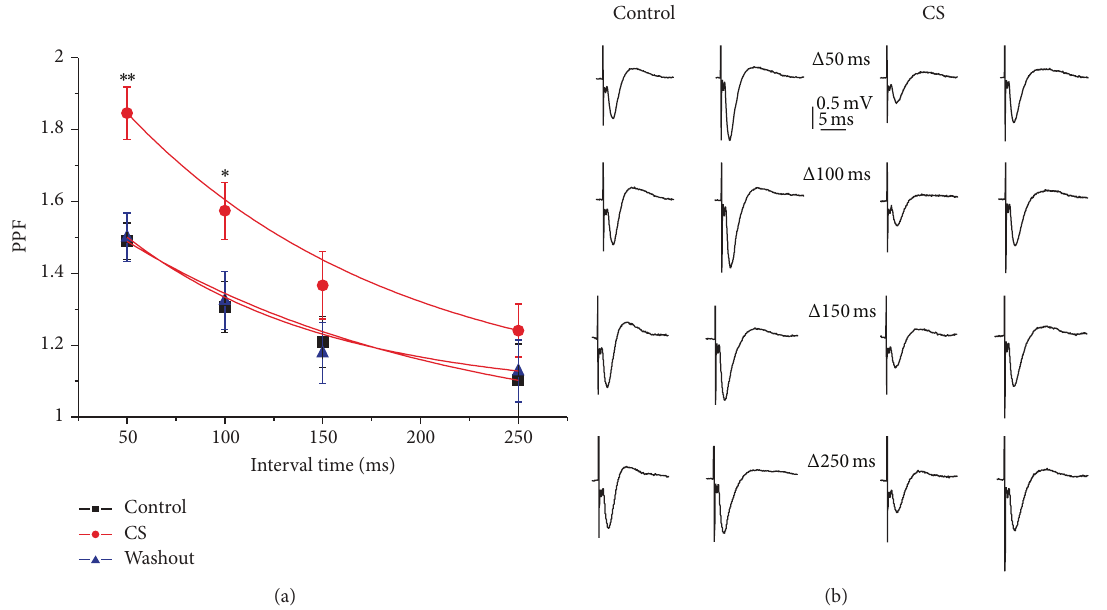
Figure 2: Effect of CS on paired-pulse facilitation (PPF). To examine if CS might affect presynaptic glutamate release, PPF was measured by calculating the percent facilitation of the second pulse fEPSP over the first pulse (fEPSP 2 slope/fEPSP 1 slope). (a) The mean PPF was plotted as a function of the interpulse interval and fitted by an exponential function. (b) fEPSPs recorded in response to paired stimuli separated by the indicated interpulse intervals ( Δ𝑡 ) in control (left) and after 20 min of CS application (300 𝜇 M) (right). The fEPSP amplitude evoked corresponds to the 40–50% of maximal response. Data are mean ± SEM of 10 slices. ∗ 𝑝 < 0.05 , ∗∗ 𝑝 < 0.01 .